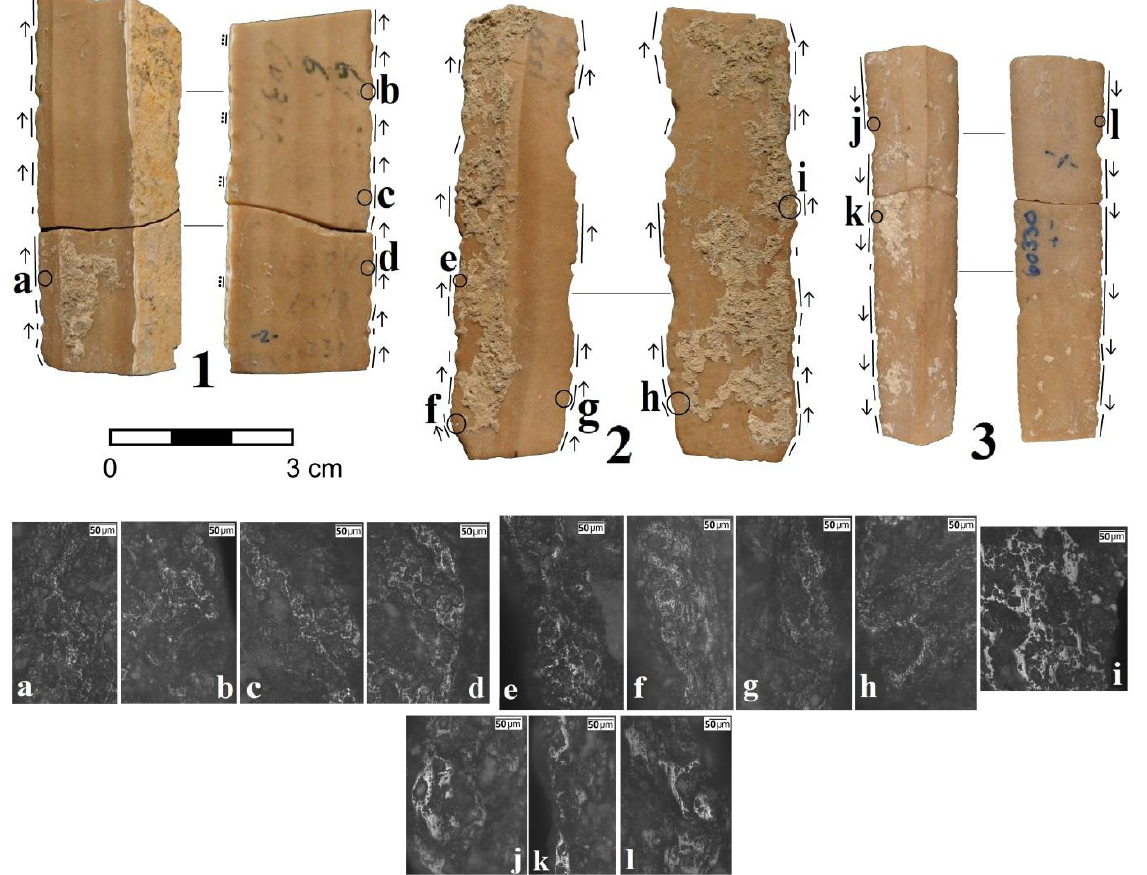
Figure 4. Microwear traces on retouched and broken Canaanean blades recycled as threshing sledge inserts. Arrows show orientation of wear traces, lines with three dots mark hafting traces. Circles (a-l) are where photomicrographs were taken (see Yerkes et al. in press ). Scalebars on the photomicrographs are 50